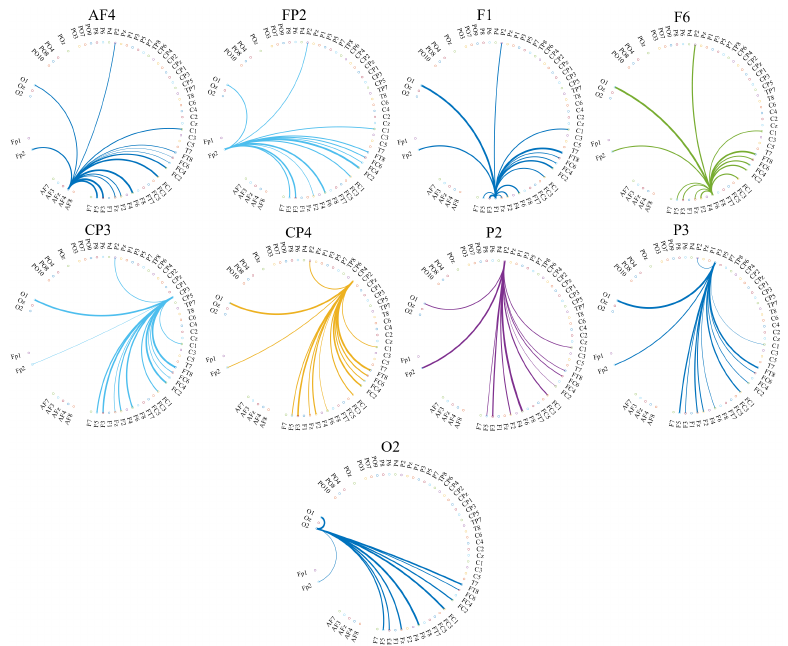
Figure 6. Eyes-Closed (EC) setting. Transfer of information from FP2, AF4, F1, F6, CP3, CP4, P2, P3, and O2 to the other cortical regions in the case of HIGH stress-susceptible group. In each subplot, the source of information transfer (e.g., AF4, FP2, etc.) is the one from which all connections are originated. They are labeled at the top of each subplot. The recipients of information (i.e., channels on the other cortical regions) are the ones at the other end of these outreaching arches.